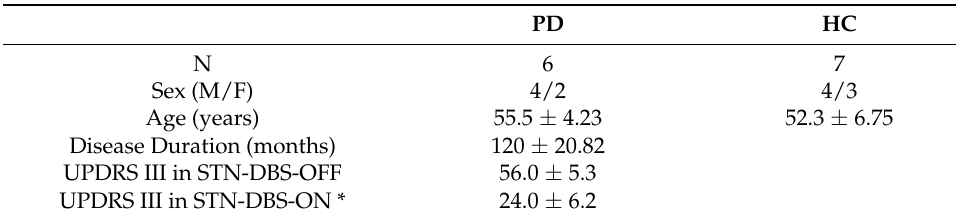
Table 1. Demographic and clinical characteristics of PD patients and healthy controls. Data are means ± standard deviation. UPDRS III: Unified Parkinson’s Disease Rating Scale part III (mo- tor symptoms). PD HC N 6 7 Sex (M/F) 4/2 4/3 Age (years) 55.5 ± 4.23 52.3 ± 6.75 Disease Duration (months) 120 ± 20.82 UPDRS III in STN-DBS-OFF 56.0 ± 5.3 UPDRS III in STN-DBS-ON * 24.0 ±